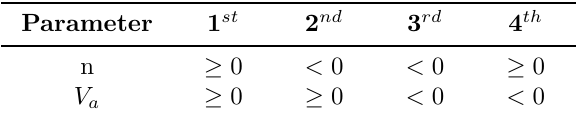
Table 1: The 4 quadrants of propeller operation pa- rameterized by RPM ( n ) and inflow velocity ( V a ) (courtesy of Smogeli (2006)). Parameter 1